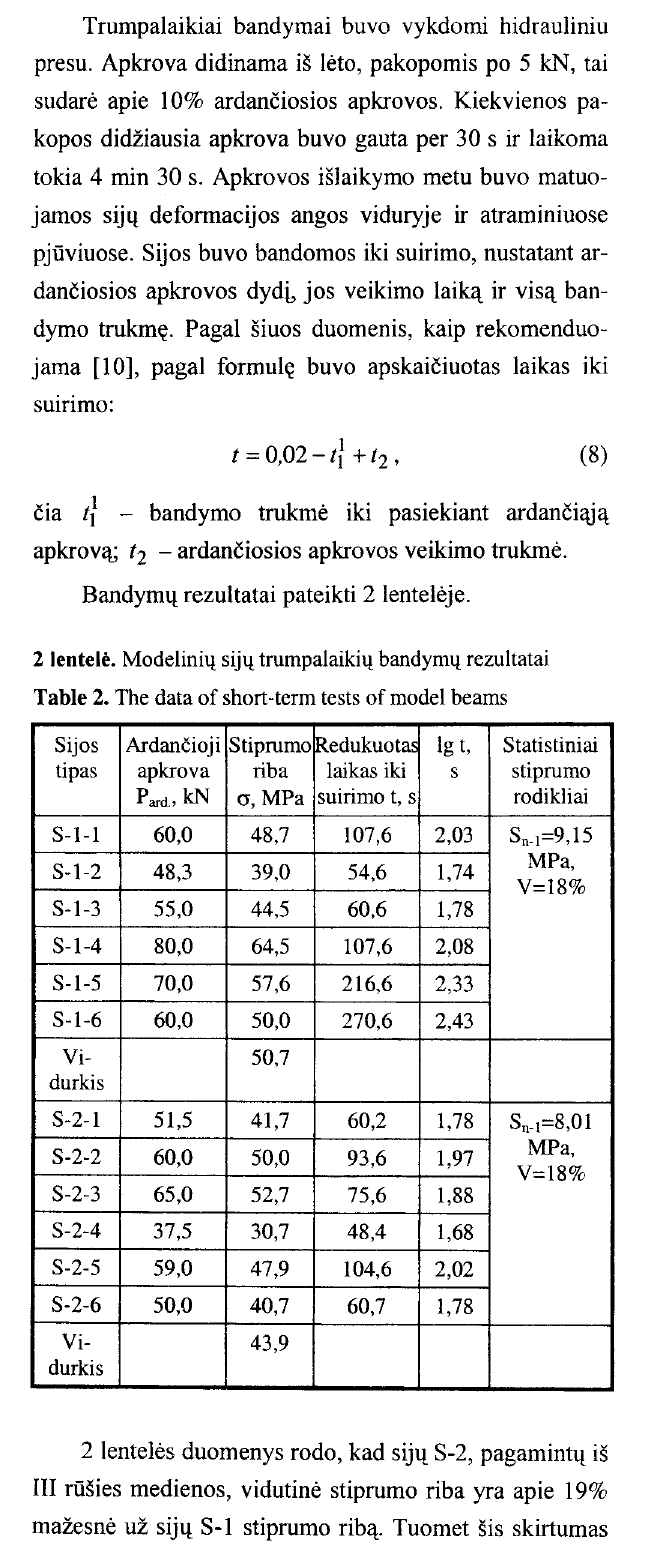
pavaizduoti 3 pav. Siame grafike ordinacill asyje atideti